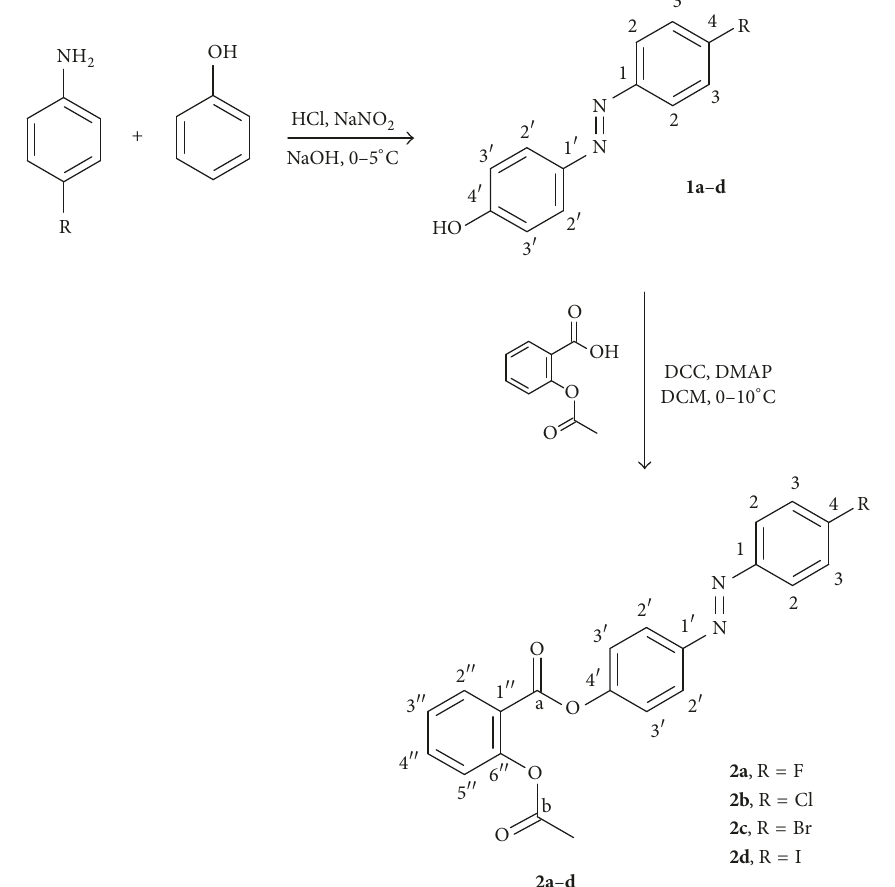
Scheme 1: Synthesis of 1a–d and 2a–d .